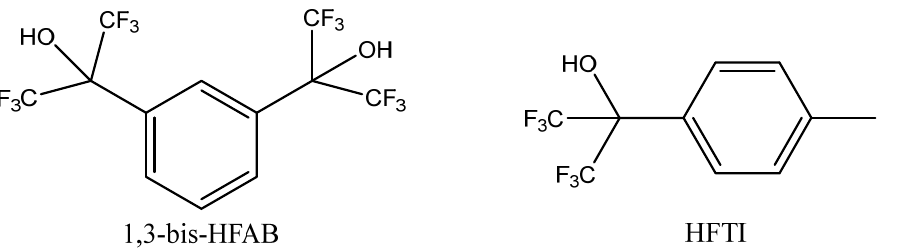
Figure 10. Structures of the most effective HBDs in co-action with Bu 4 NBr for the carbonation of